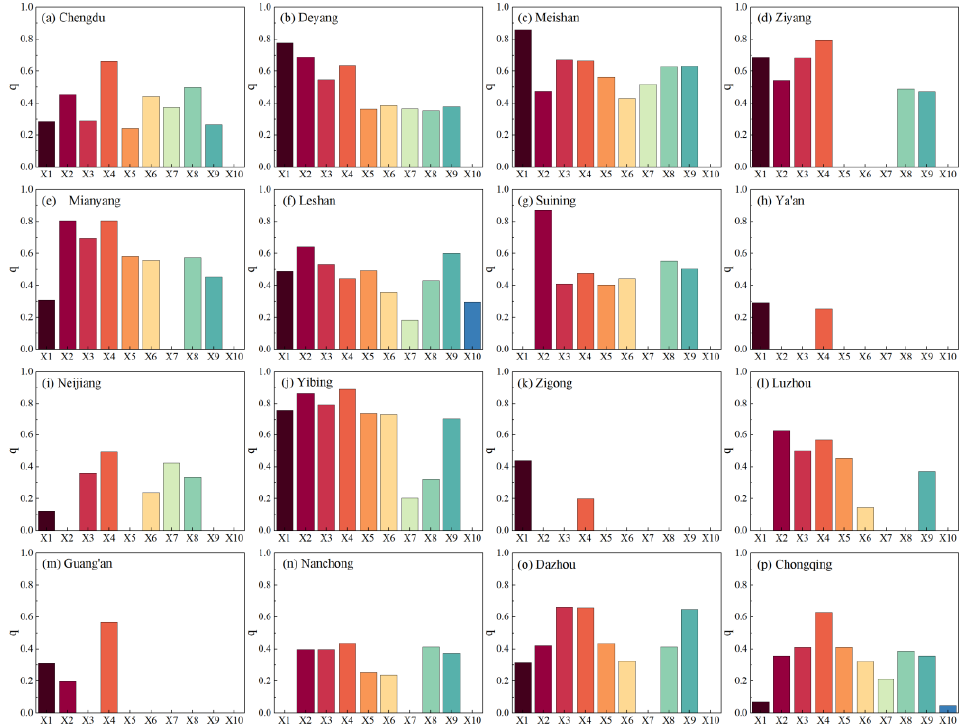
Figure 6. Distribution of the influence of each influence factor on carbon emission in Chengdu and Chongqing region from 2005 to 2017 (P < 0.05). Chongqing region from 2005 to 2017 ( p <